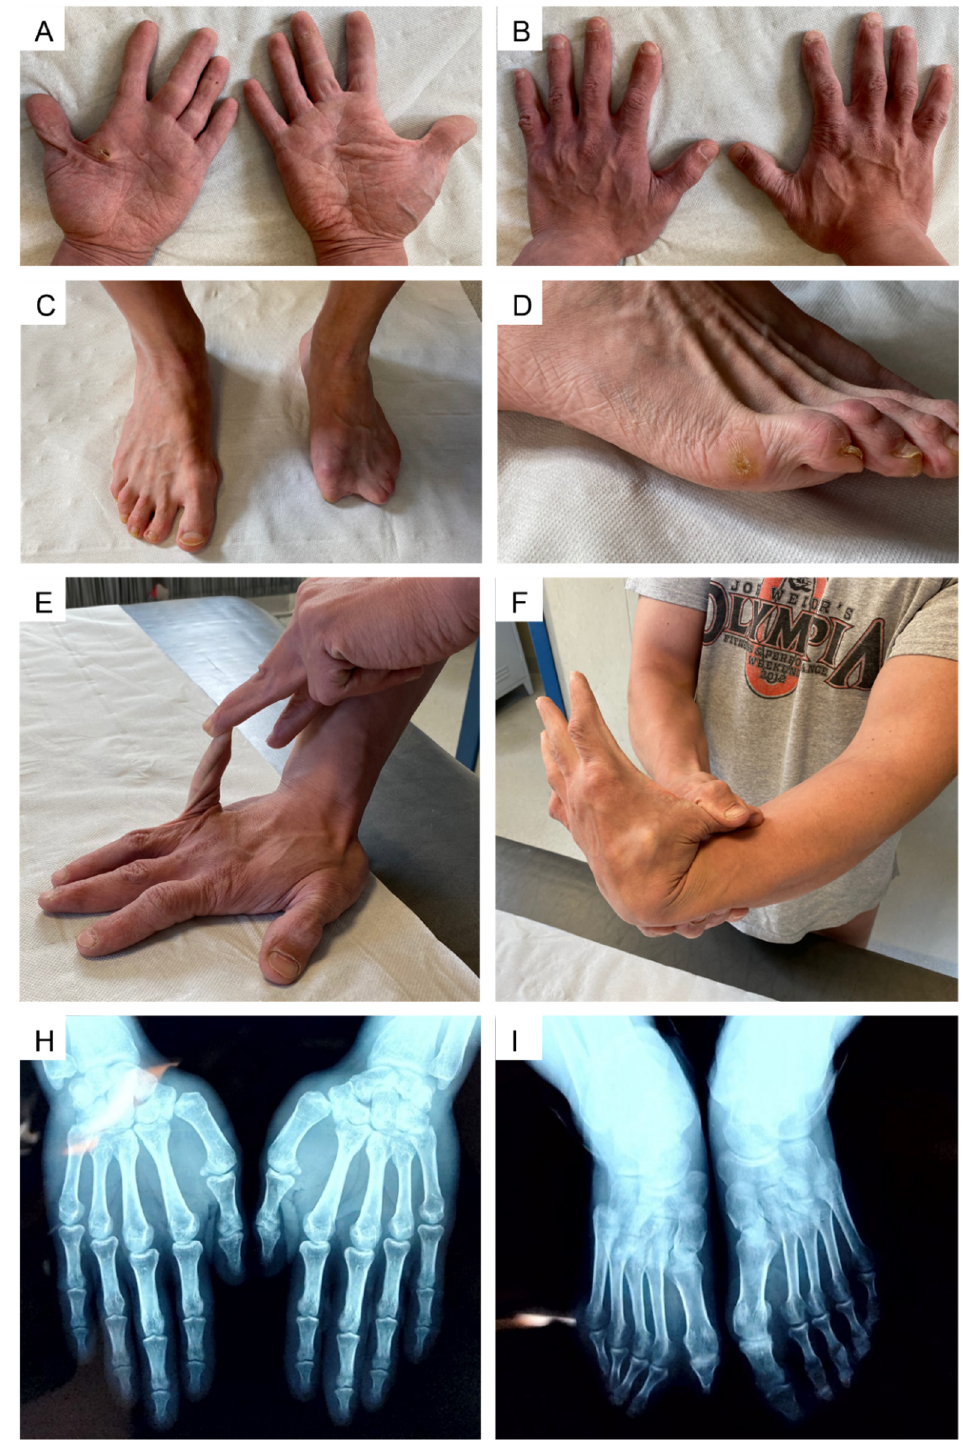
Figure 2. Extremities and joints assessment: ( A , B ), progeroid aspect of the hands with apparently short “stubby” fingers; ( C , D ) right foot with hammer toes; left foot with aplasia/hypoplasia of phalanges; ( E , F ) joint hypermobility of the V and I finger. Beighton score was 7/9, including distal hypermobility. ( H ): radiogram of the hands; ( I ): radiogram of the feet. Skin was dry, markedly hyperextensible (>3 cm dorsum of the hand, >5 cm elbow and neck regions), and translucent, with visible vascular architecture, especially around the neck and chest. Some scars were atrophic, with one on the left elbow presenting with subcutaneous spheroids, while others being hemosiderotic or having a cigarette-paper-